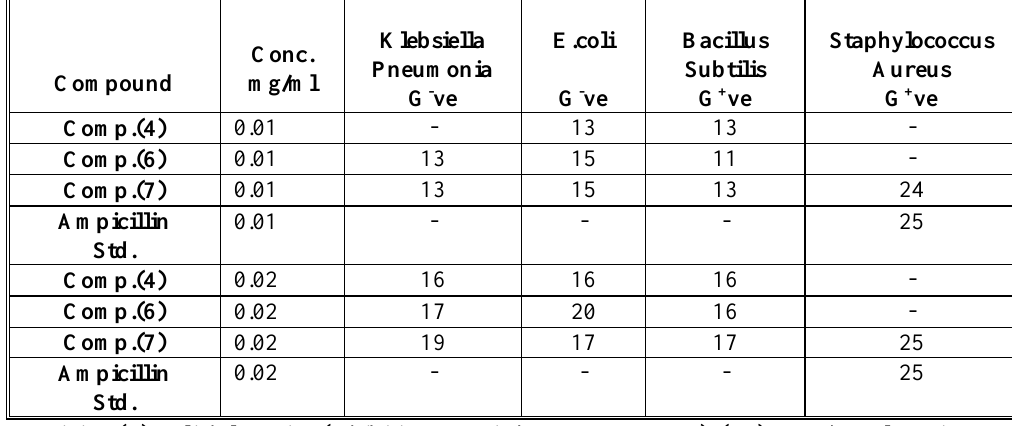
Table (1) The antibacterial activities of synthesized compounds.